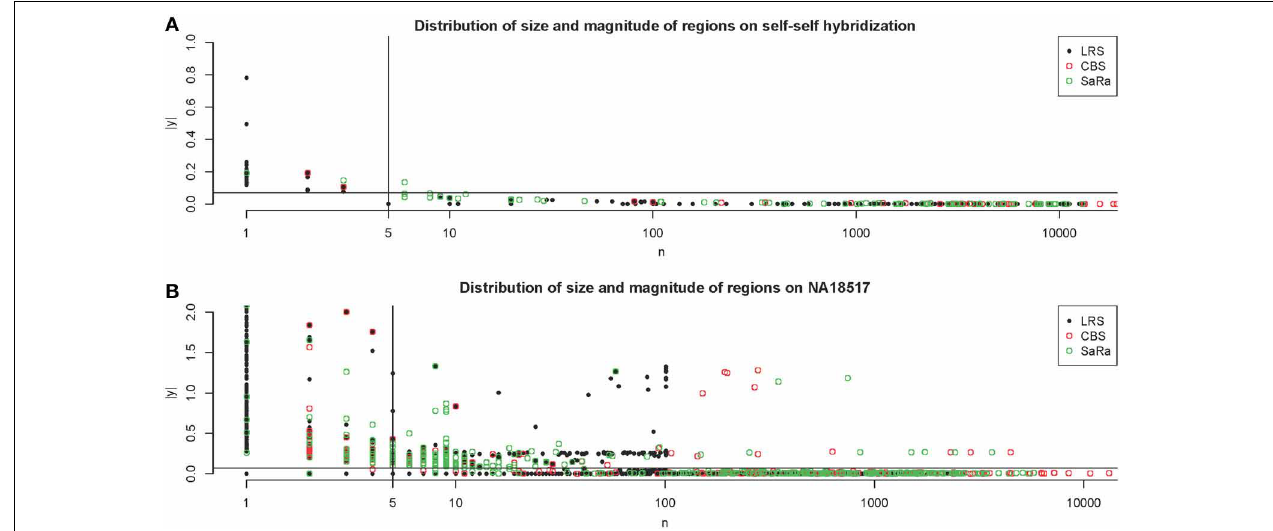
FIGURE 4 | Distribution of regions on Self-Self Hybridization and sample NA18517. (A) shows the distribution of regions for each method on one technical replicate of the self-self hybridization. The thresholds used here are 5 probes and 1.5 times the median absolute